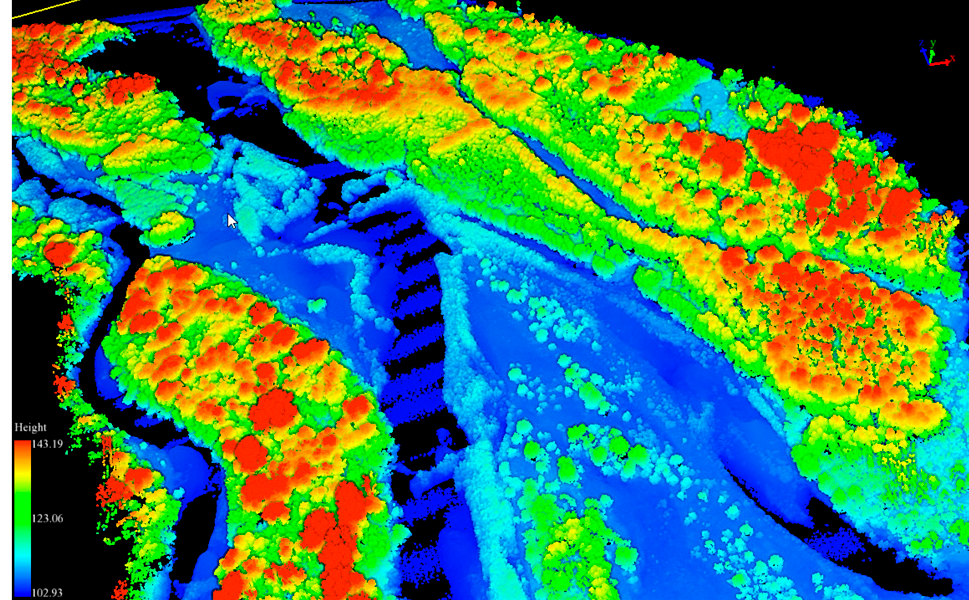
Figure 6. Example of the UAV-LiDAR point cloud for the Southern Island, representing the heterogenous landscape characterized by different land covers of the studied islands. Visualization made in LiDAR 360 viewer.